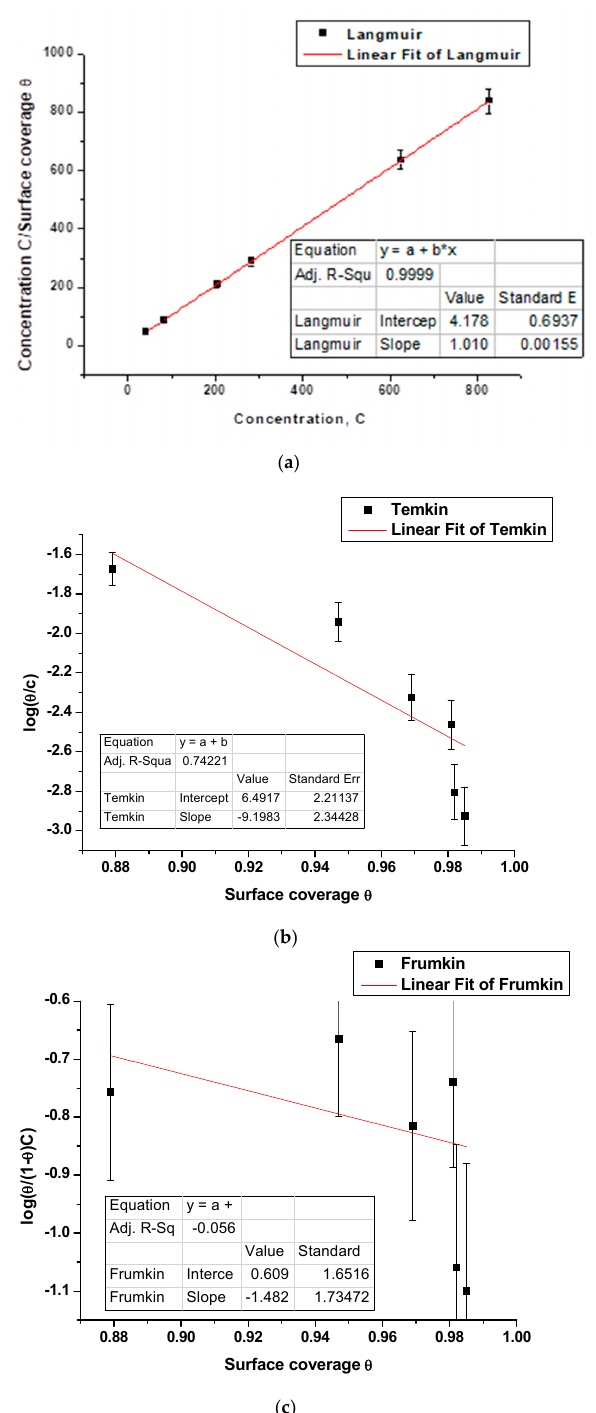
Figure 10. Adsorption isotherm from EIS plots for Harmal extract concentrations (ppm) on C ‐ steel in 0.25 M H 2 SO 4 medium: ( a ) Langmuir model, ( b ) Temkin model, and ( c ) Frumkin model.